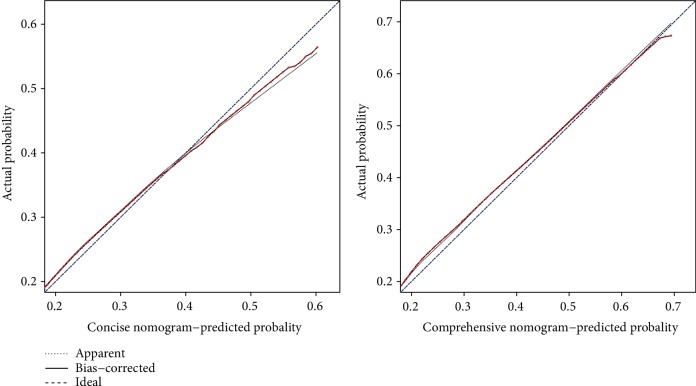
Calibration plots by deciles for nomograms: 7-year incidence of diabetes in the concise nomogram and the comprehensive nomogram, respectively. (The nomogram-predicted probabilities of diabetes incidence are plotted on the x-axis; actual probabilities of diabetes incidence are plotted on the y-axis. Dashed lines along the 45-degree line through the origin point represent perfect calibration models, in which the predicted probabilities are identical to the actual probabilities.)